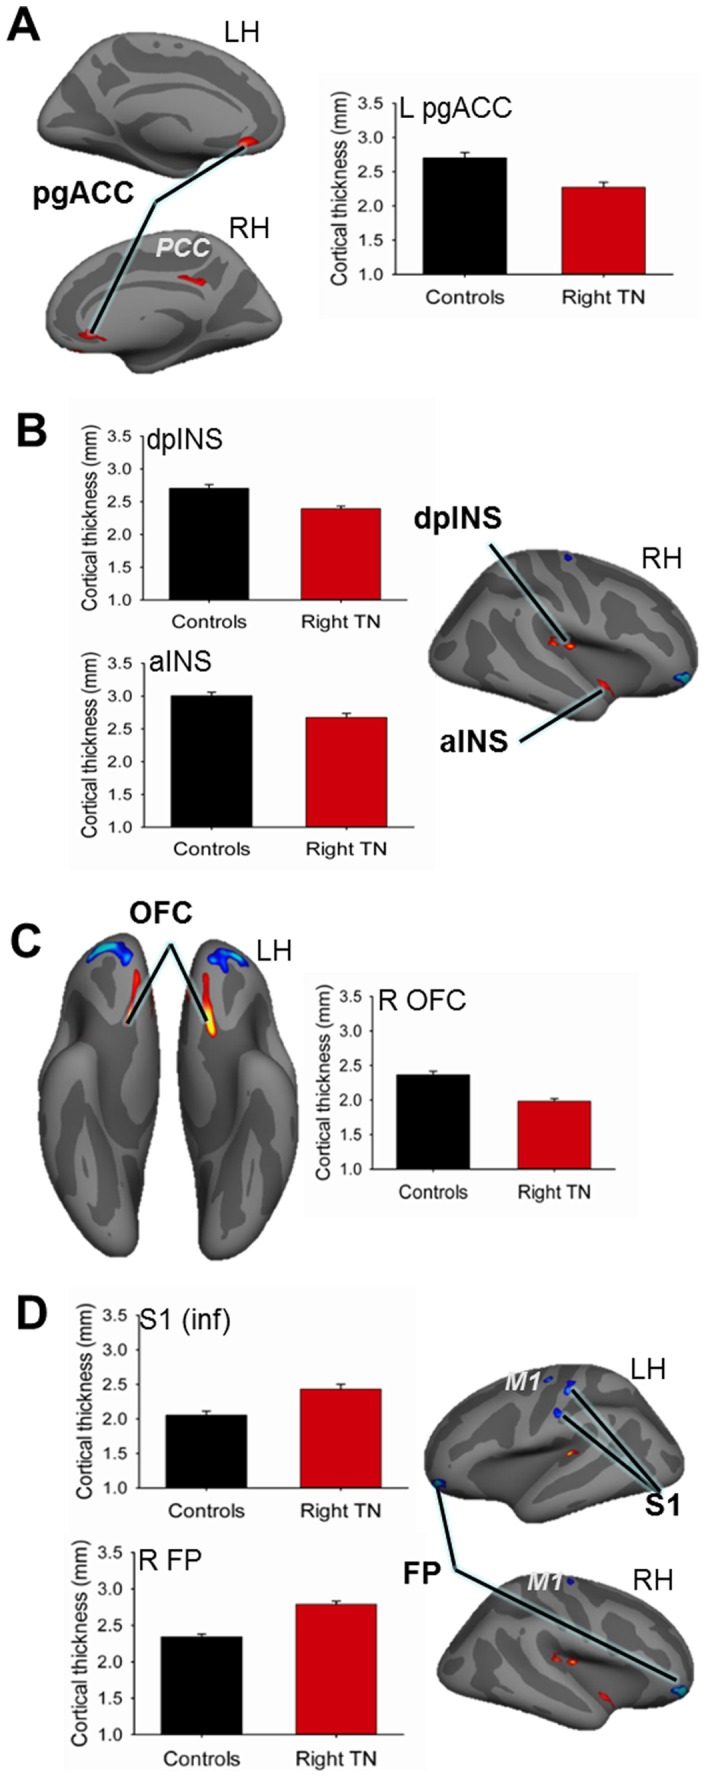
Cortical thickness abnormalities in trigeminal neuralgia patients.CTA revealed significant group differences in several cortical brain regions. Red clusters indicate thinner cortex in patients compared to controls (p<0.05, corrected). Prominent findings of cortical thinning in TN are shown in panels A–C, including graphs of mean cortical thickness values ± SEM (in mm): controls (black bars), patients (red bars). Areas of cortical thickening in TN are highlighted in panel D. Thinner cortex in TN was observed in: (A) the bilateral pgACC; graph illustrates thickness for left cluster; (B) the right insular cortex including the dpINS and the ventral aINS, and (C) the bilateral ventral OFC; graph illustrates thickness for right OFC cluster. TN patients had thicker cortex in (D) the bilateral FP and M1, and contralateral (left) S1; graphs illustrate thickness for right FP cluster and the inferior S1 cluster (putative face area). Abbreviations: LH =  left hemisphere; RH =  right hemisphere; R =  right; L =  left; pgACC =  pregenual anterior cingulate cortex; PCC =  posterior cingulate cortex; aINS =  anterior insula; dpINS =  dorsal posterior insula; OFC =  orbitofrontal cortex; FP =  frontal pole; M1 =  primary motor cortex; S1 =  primary somatosensory cortex.